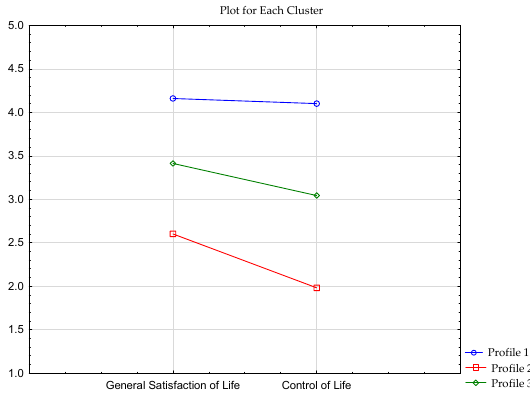
Figure 1. Clusters of OHQ in the sample of respondents.